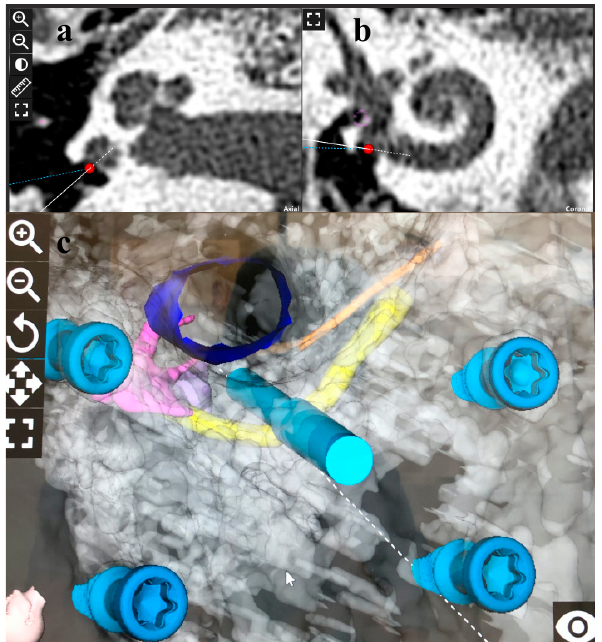
Figure 3. ( a , b ) Pre-op cone beam computed tomography axial and coronal views showing the target plan. ( c ) Pre-op planning with 3D reconstruction of all relevant anatomical structures; yellow color showing facial nerve, orange color showing chorda tympani, dark blue color showing external auditor canal, pink color showing incus and malleus, purple color showing stapes.